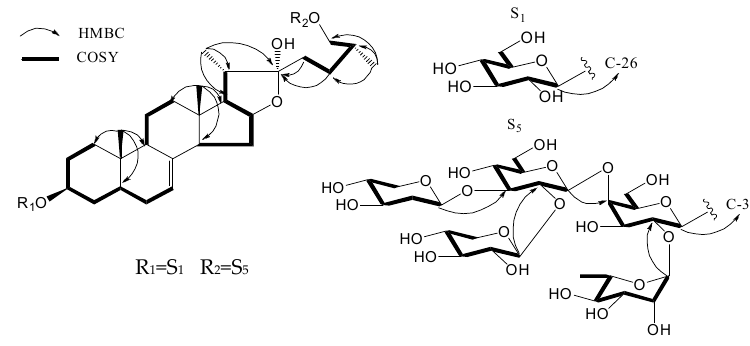
Figure 2. Key COSY and HMBC correlations for 1 .